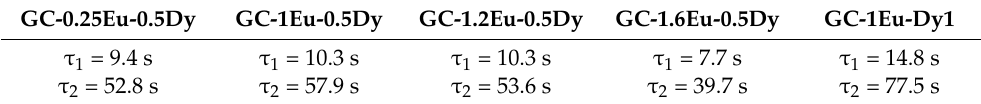
Table 9. Lifetimes of the persistent luminescence kinetics excited at 354 nm for the co-doped samples.